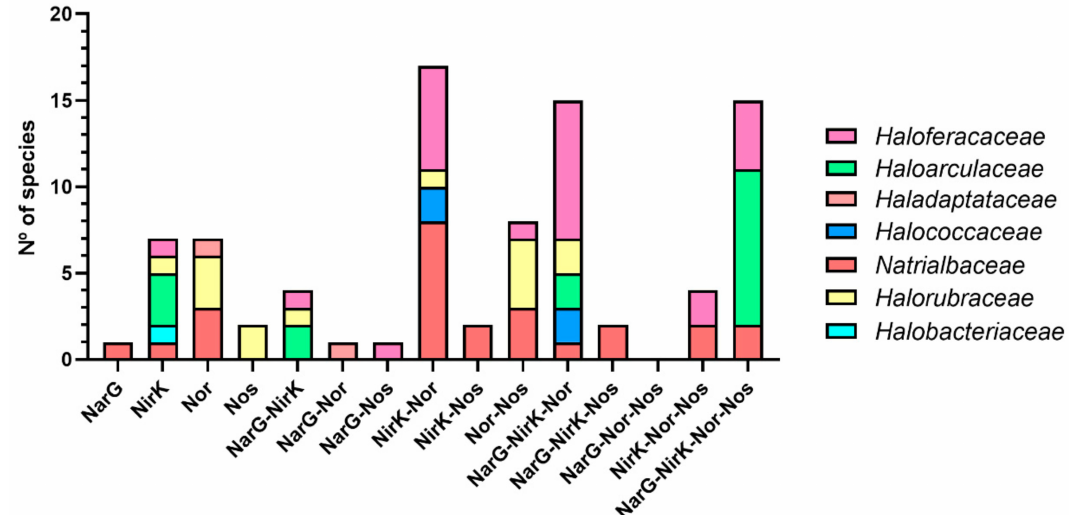
Figure 2. Co-occurrence of NarG, NirK, Nor and Nos in haloarchaea. Number of species in each family that present one, two, three or four genes encoded denitrification